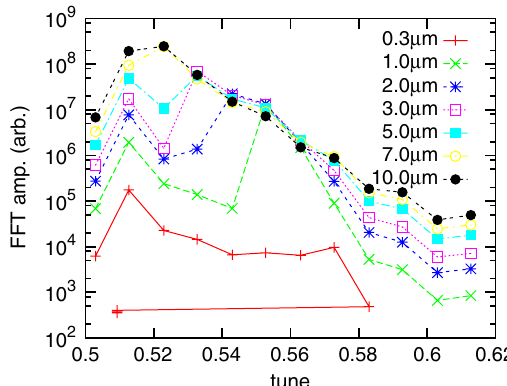
FIG. 4. Illustration of horizontal spectra of the centroid motion for the different 11 excitation frequencies. The IP equivalent excitation amplitude is 1 (cid:3) m for all excitation frequencies.